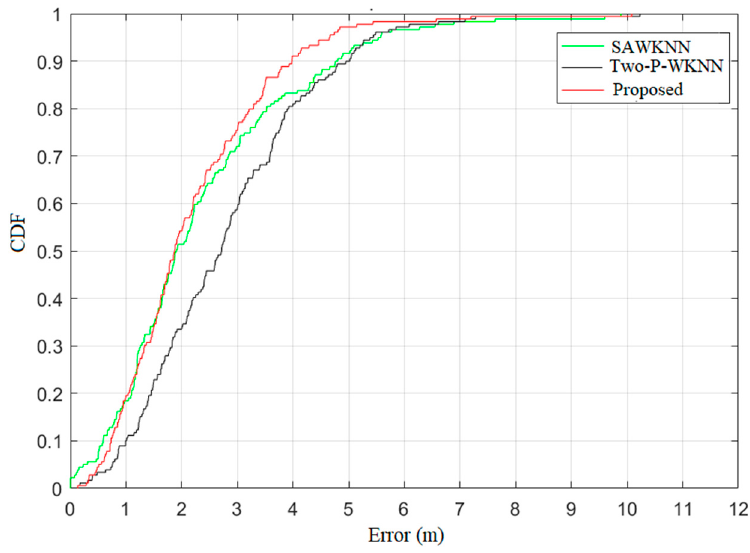
Figure 8. Position errors’ CDF of the three algorithms.